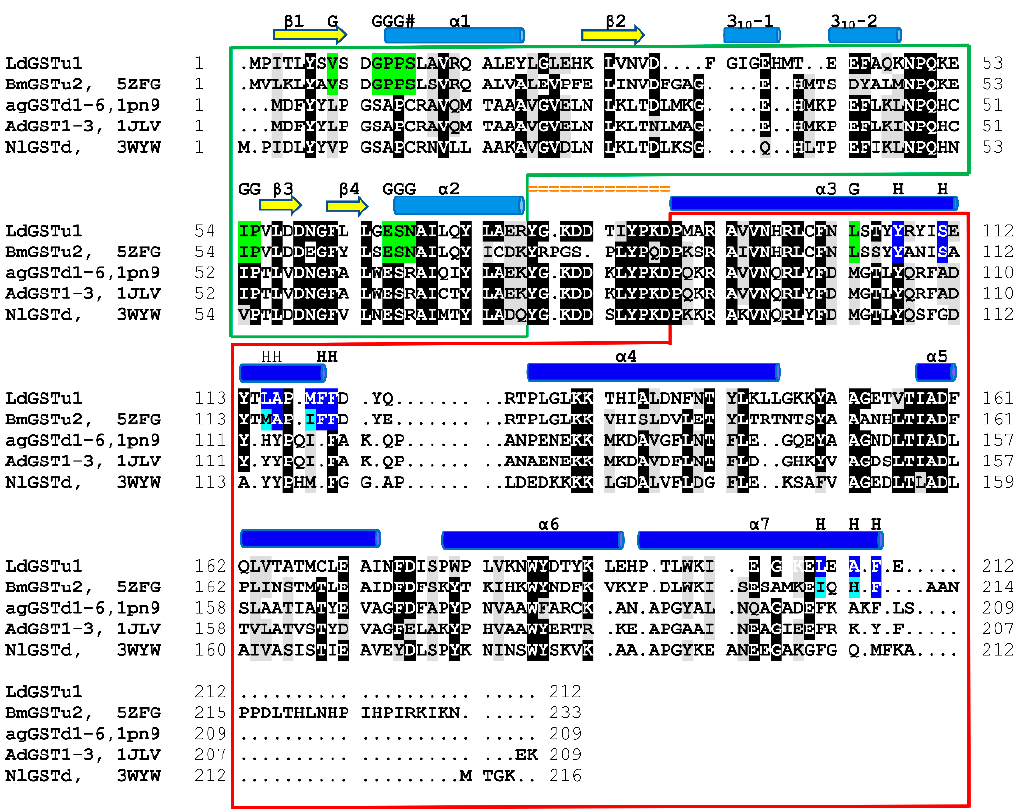
Figure 3. Structural sequence alignment of LdGSTu1 with highest sequence identity insect GSTs deposited in PDB. Chimera was used to superpose LdGSTu1 crystal structure with 5ZFG, 1PN9, 1JLV, and 3WYW to generate a multiple structure sequence alignment. Sequence amino acids are highlighted black for 80% identity and gray for 80% similarity. Secondary structural element positions are mapped and shown with yellow arrows for β -strands, and blue cylinders for helices. Domain distribution is depicted as boxed green for the N-term domain and boxed in red for the C-term domain. The linker region is mapped with orange equal signs. G-site residues are highlighted green and marked with a G. H-site residues are highlighted blue and marked with an H.